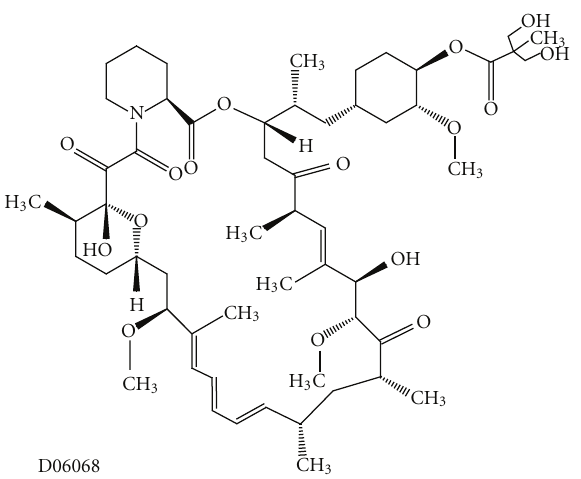
Figure 11: Molecular structure of temsirolimus extracted from KEGG database [9].